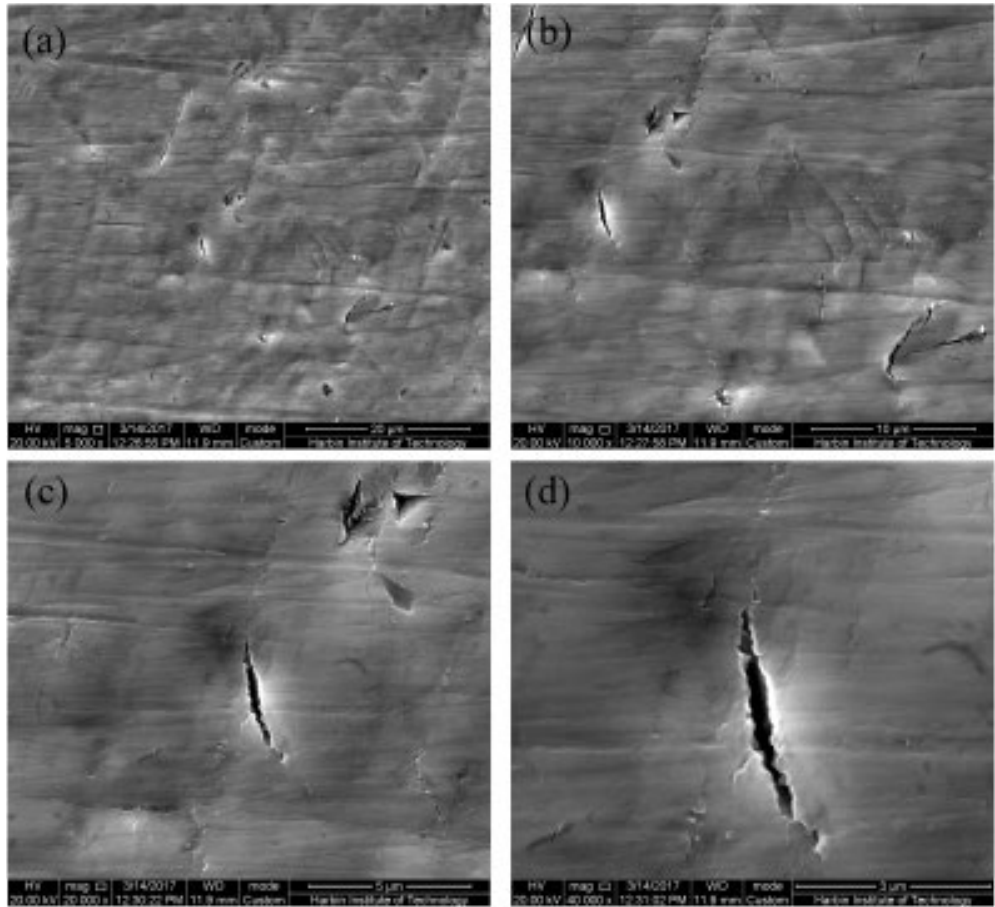
Figure 5. Typical morphology of microcracks of damaged titanium alloy sheet before electropulsing. ( a – d ) are Magnified 5,000, 10,000, 20,000 and 40,000 times SEM image,